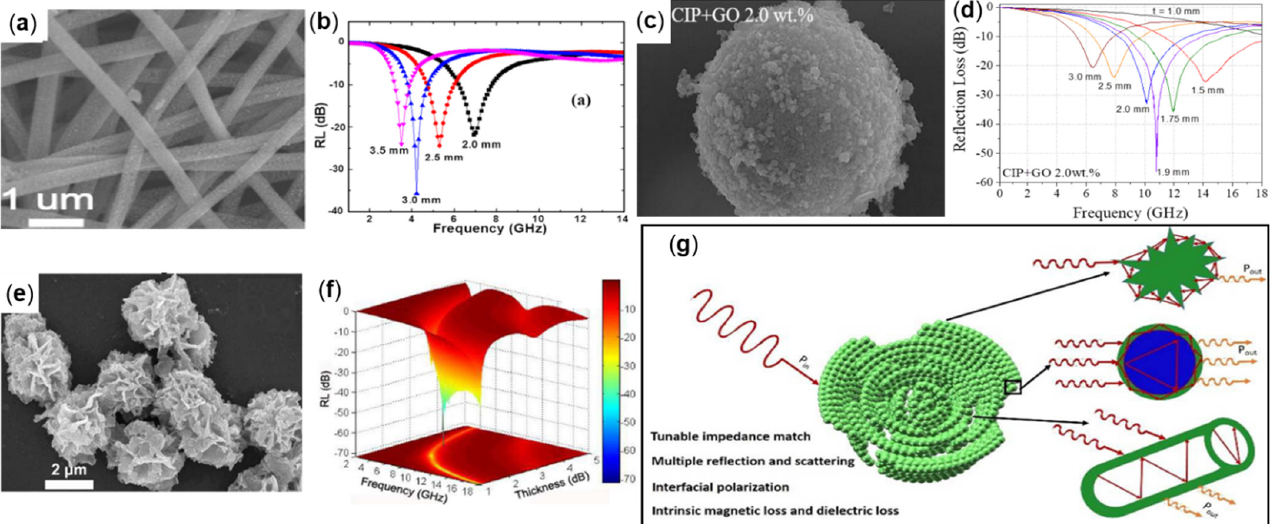
Figure 10. ( a ) SEM and ( b ) RL plot of Fe-C, reproduced with permission from Ref. [71], Copyright 2014, Elsevier. ( c ) SEM and ( d ) RL plot of GO@CIPs, reproduced with permission from Ref. [78],